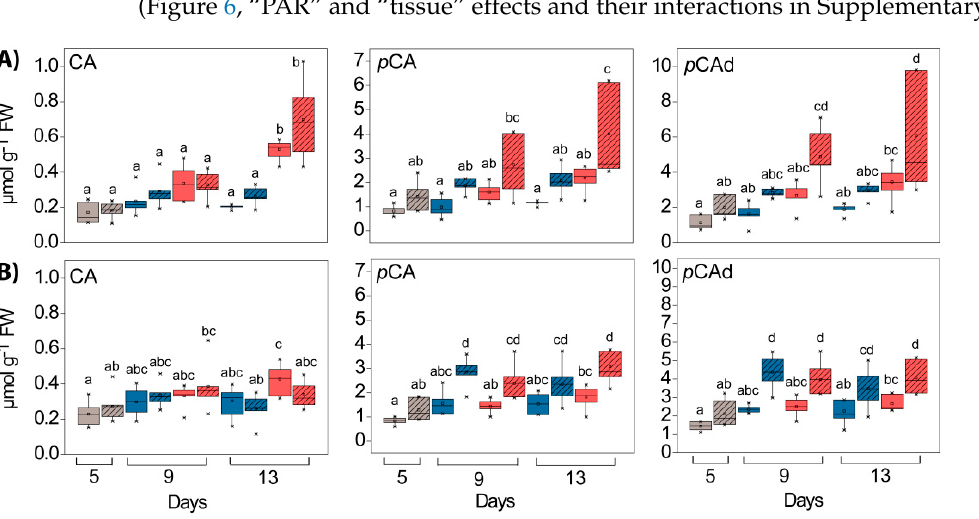
Figure 5. Changes in the composition of hydroxycinnamates in GL (solid boxes) and WL (striped boxes) of P. zonale plants before (5 d, grey) and after four (9 d) and eight days (13 d) of high light exposure (HL, 800 µmol m –2 s –1 , red bars) compared to plants exposed to low light (LL, 180 µmol m –2 s –1 , blue bars) at ( A ) optimal temperature of 25 °C ( HL ) and ( B ) lower temperature of 18 °C ( Cold + HL ). Values are shown in µmol g –1 FW ± SE, n = 5–9. Different letters indicate statistically significant differences between different PAR intensities, time points, and leaf tissues ( p < 0.05) according to Tukey’s post hoc test. CA, caffeic acid; p -CA, p -coumaric acid; p -CAd, p -coumaric acid derivative.